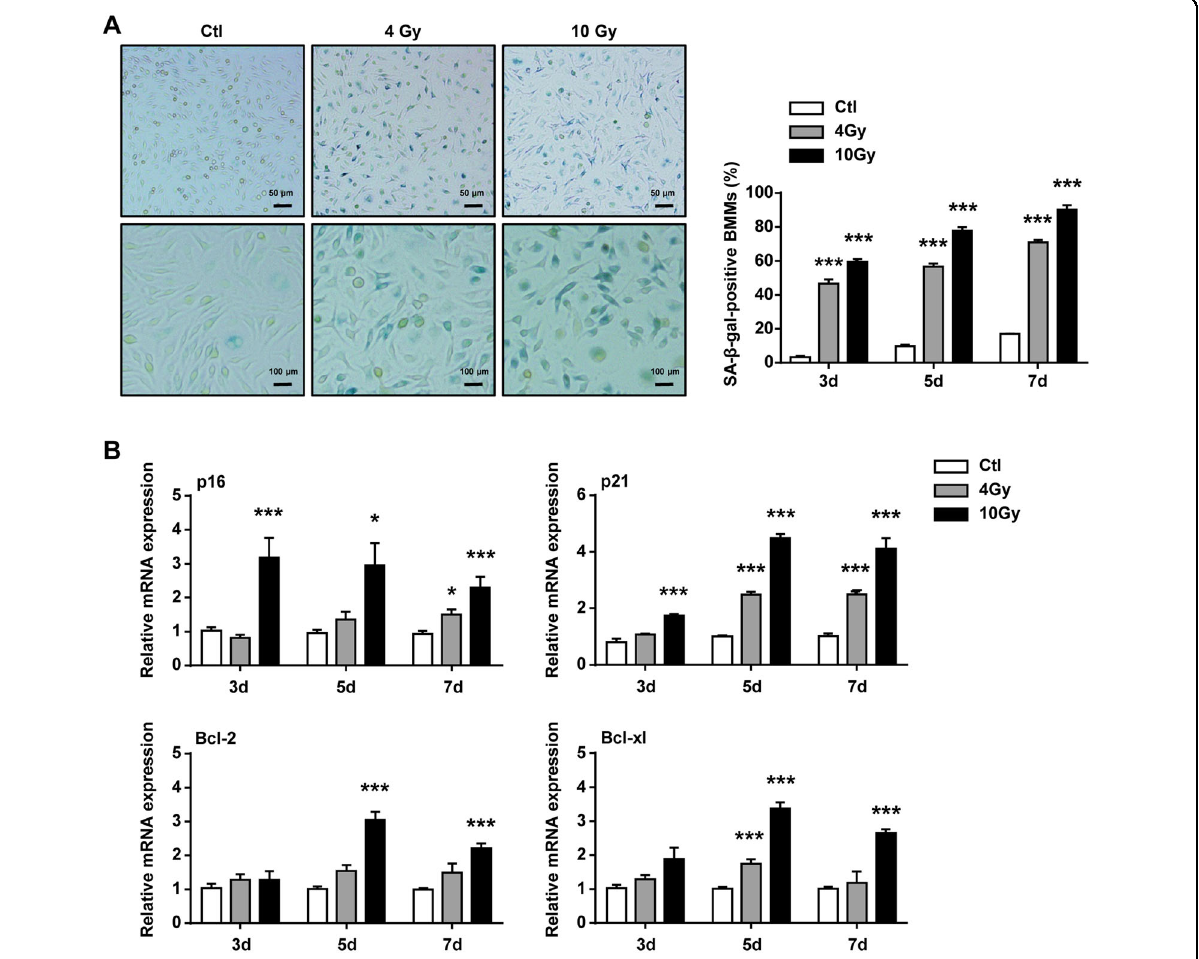
Fig. 1 Bone marrow-derived monocytes/macrophages (BMMs) had senescent phenotype after IR. BMMs were exposed to IR at doses of 0 (ctl), 4, or 10 Gy. BMMs were collected at intervals after IR and in controls. A Representative images of SA- β -gal staining (scale bar, 100 μ m) and quanti fi cation of SA- β -gal + BMMs. B qRT – PCR expression of p16, p21, Bcl-2, and Bcl-xl were measured relative to Gapdh levels. Data are expressed as mean ± SEM of fi ve independent experiments, *** P < 0.001, ** P < 0.01 and * P < 0.05 compared with the corresponding